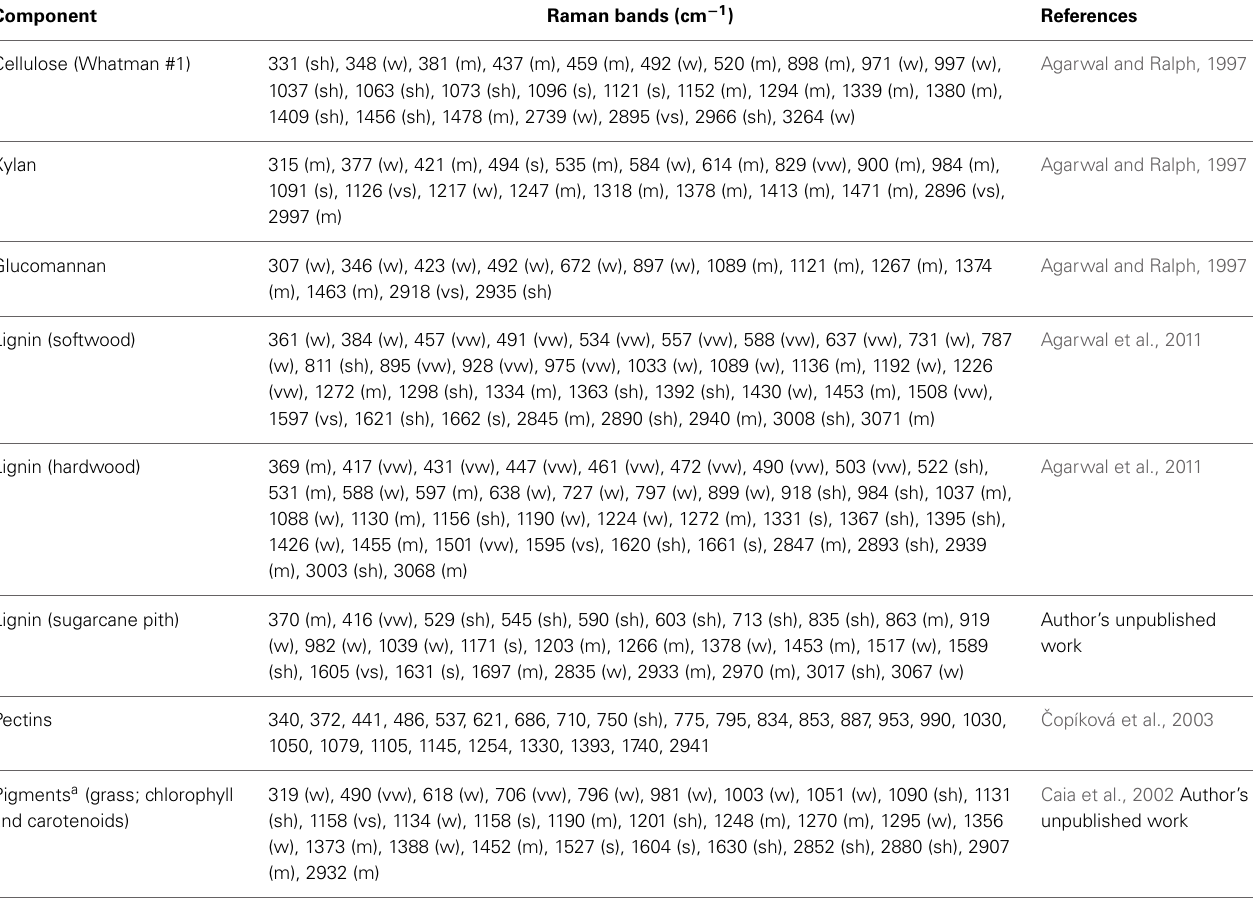
Table 1 | Raman band positions of various plant biomass components.